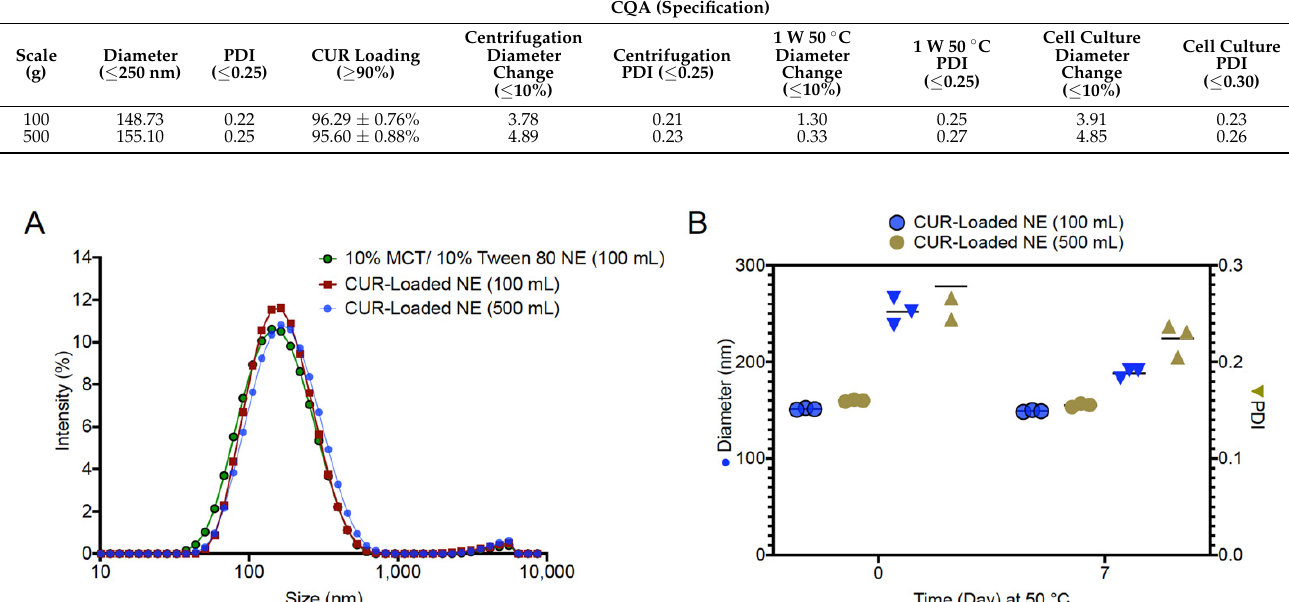
Figure 7. ( A ) Droplet size comparison of 10% MCT oil/10% Tween 80 nanoemulsions with and without 0.1% ( w / w ) CUR. CUR nanoemulsions were manufactured at 100 g and 500 g scales. ( B ) droplet diameter and PDI comparisons of CUR-loaded nanoemulsions after 1 week of storage at 50 °C.